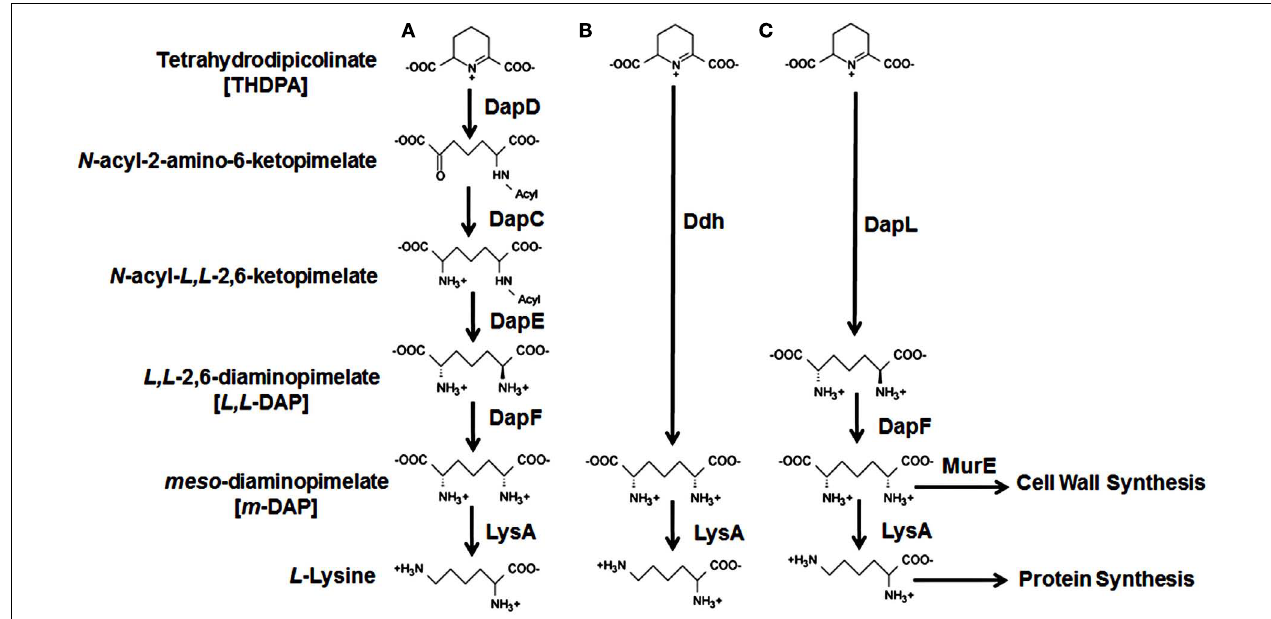
pathways, (B) the meso -diaminopimelate dehydrogenase pathway, and (C) the L,L -diaminopimelate aminotransferase (DapL) pathway.The abbreviations of the enzymes along with the enzyme reaction definitions are listed in Table 1